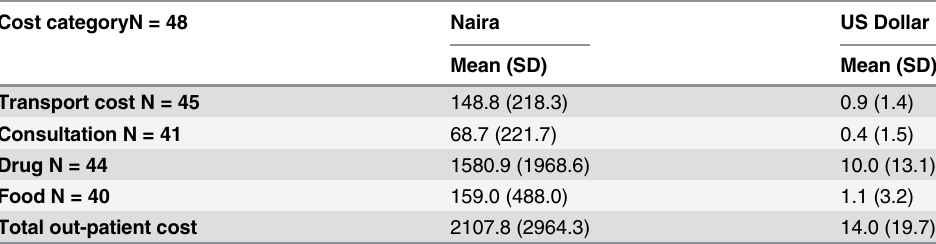
Table 4. Treatment costs for an out-patient